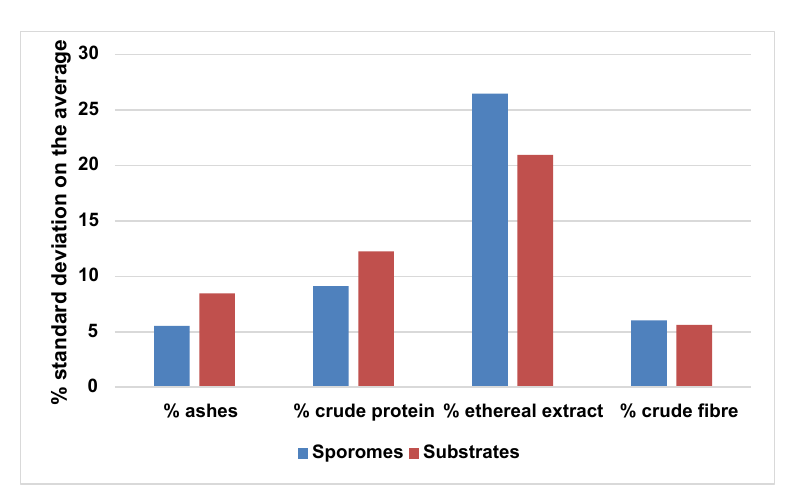
Figure 10 Synopsis of different bromatological profiles in sporomes (T1–T7) and substrates.